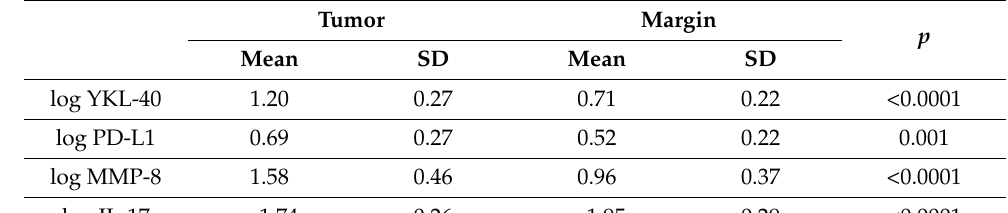
Figure 4. Immune in fi ltration and immunogenicity analysis for YKL-40 (CHI3L1) based on TCGA- COAD data. ( A ) In fi ltration of immune cells for CHI3L1 expression groups calculated by CIBERSORT algorithm. ( B ) Immune-related scores for high and low CHI3L1 expression groups. Table 2. Levels of YKL-40, PD-L1, MMP-8, IL-17, and IL-23 proteins in tumor and margin presented as log-transformed ng/mg of protein. Paired Student’s t -test.